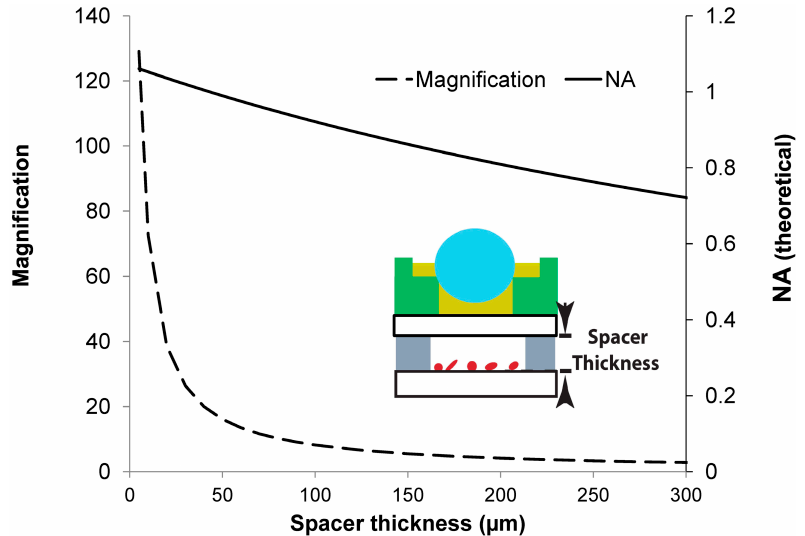
Figure 5. Dependence of the magnification and NA of the µOIL chip on spacer